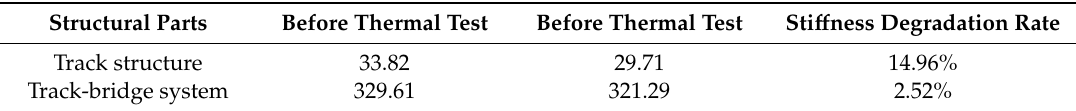
Table 4. Sti ff ness degradation after thermal